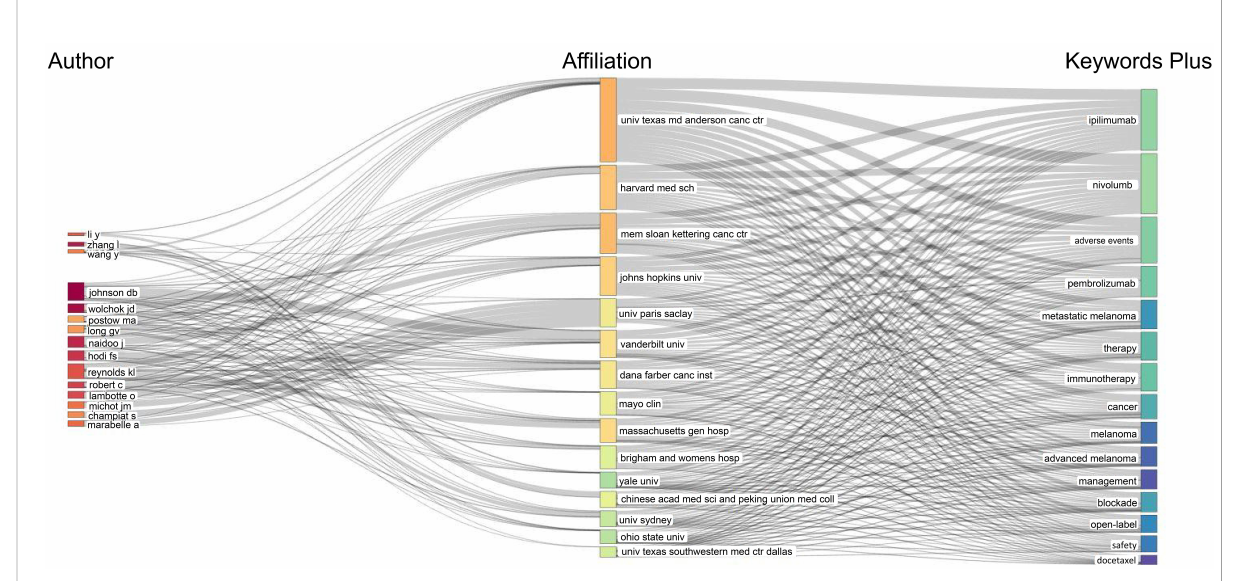
FIGURE 6 Three- fi eld plot of the keywords plus analysis on irAEs (left fi eld: authors; middle fi eld: af fi liations; right fi eld: keywords